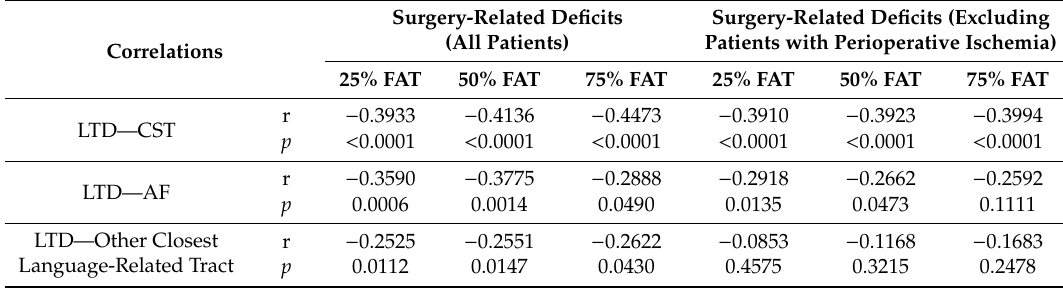
Table 5. Correlations between lesion-to-tract distances (LTDs) and surgery-related motor or language